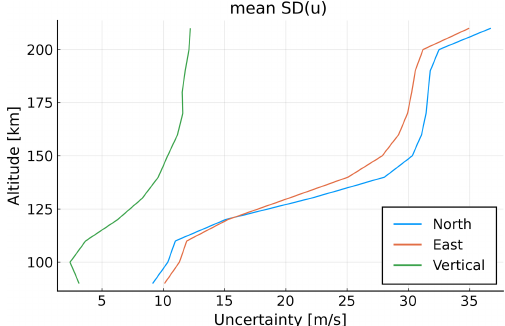
Figure 9. Uncertainty in neutral wind estimates. Because the un- certainties vary little horizontally, the values are averaged for every